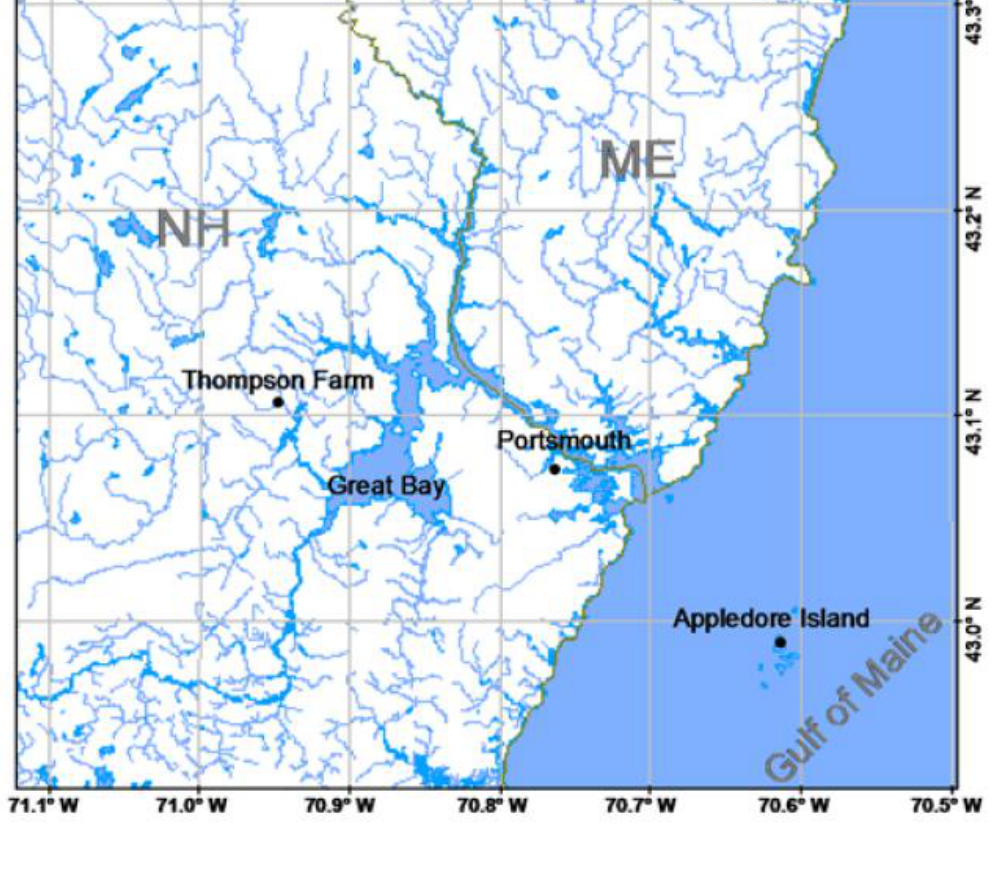
Figure 11. Region of interest in this study in coastal New Hampshire. Appledore Island is located in the Gulf of Maine ~12 km offshore, while Thompson Farm is ~25 km